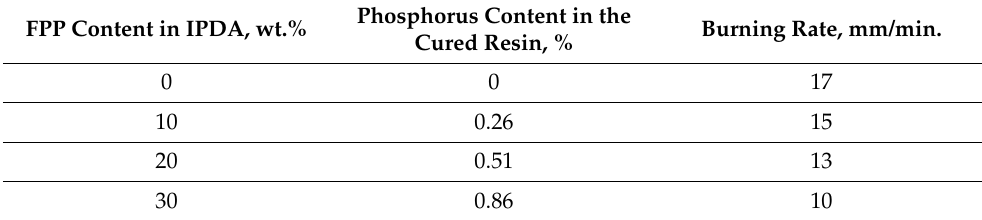
Table 6. Fire resistance test results for the cured DER-354. FPP Content in IPDA, wt.%